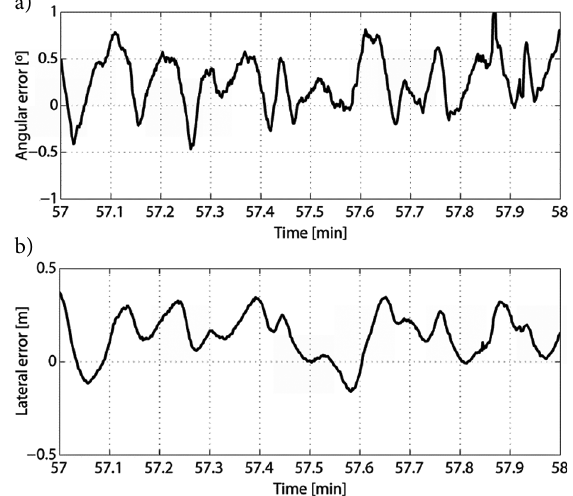
Fig. 19. Evolution of the input variables for lateral